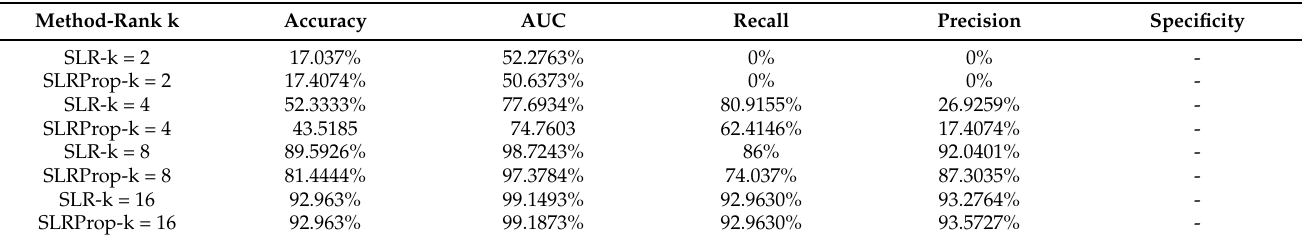
Table A1. SLR vs. SLRProp Cifar10.